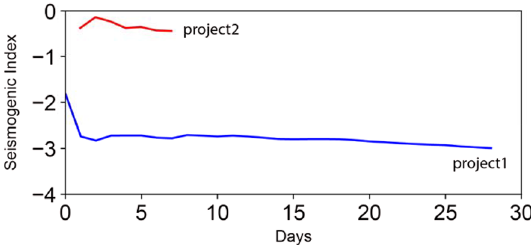
Figure 5. Calculated seismogenic index. Time history of the seismogenic index during sampling periods for project 1 (blue line) and project 2 (red line). The minimum value of Σ during the calibration period is used to forecast the maximum magnitude during the subsequent time period.